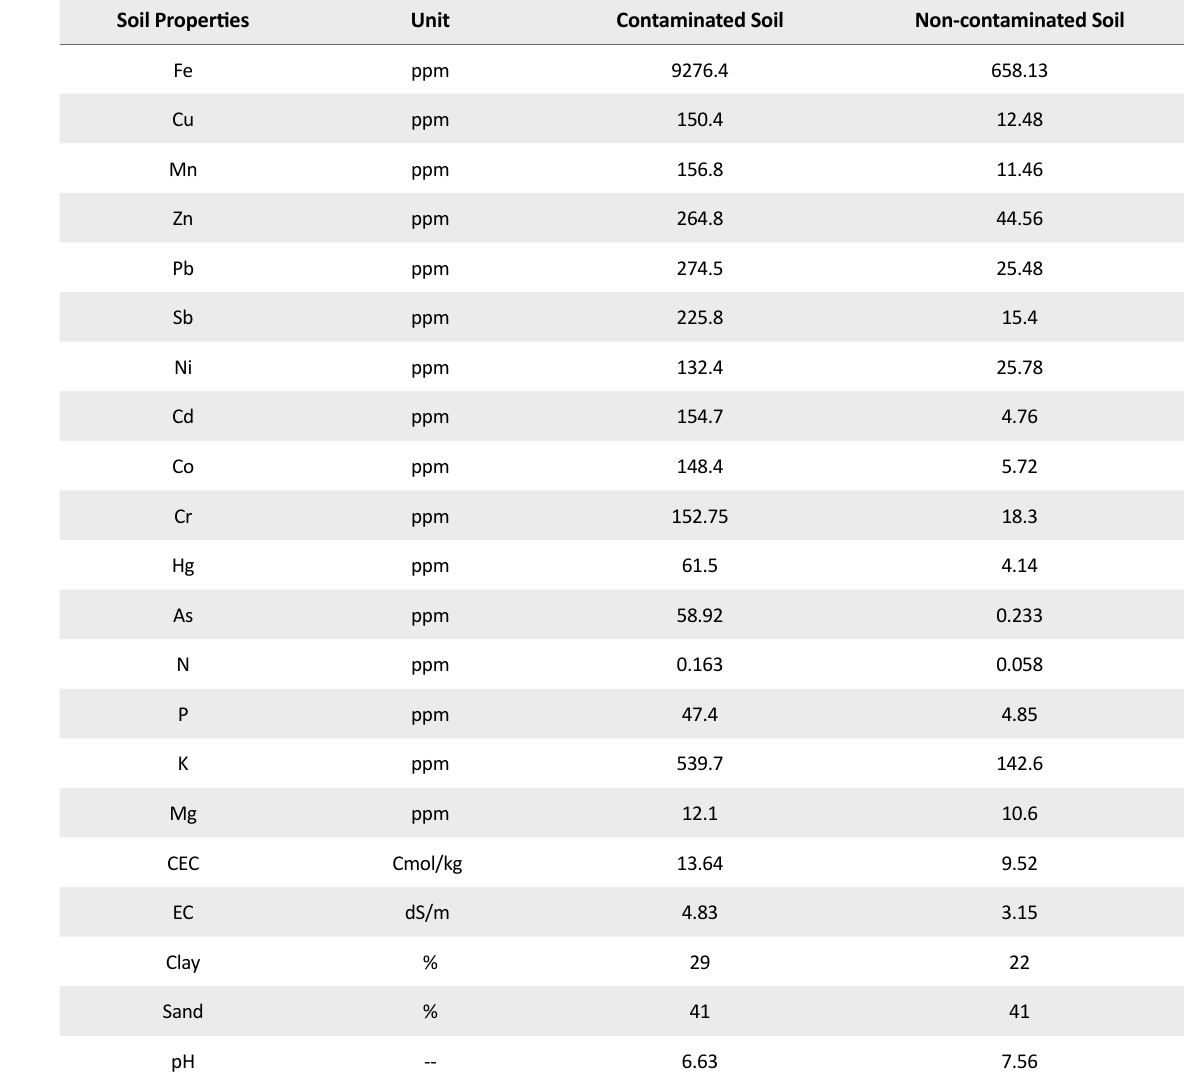
Table 1. The physical and chemical properties of contaminated and non-contaminated soils Soil